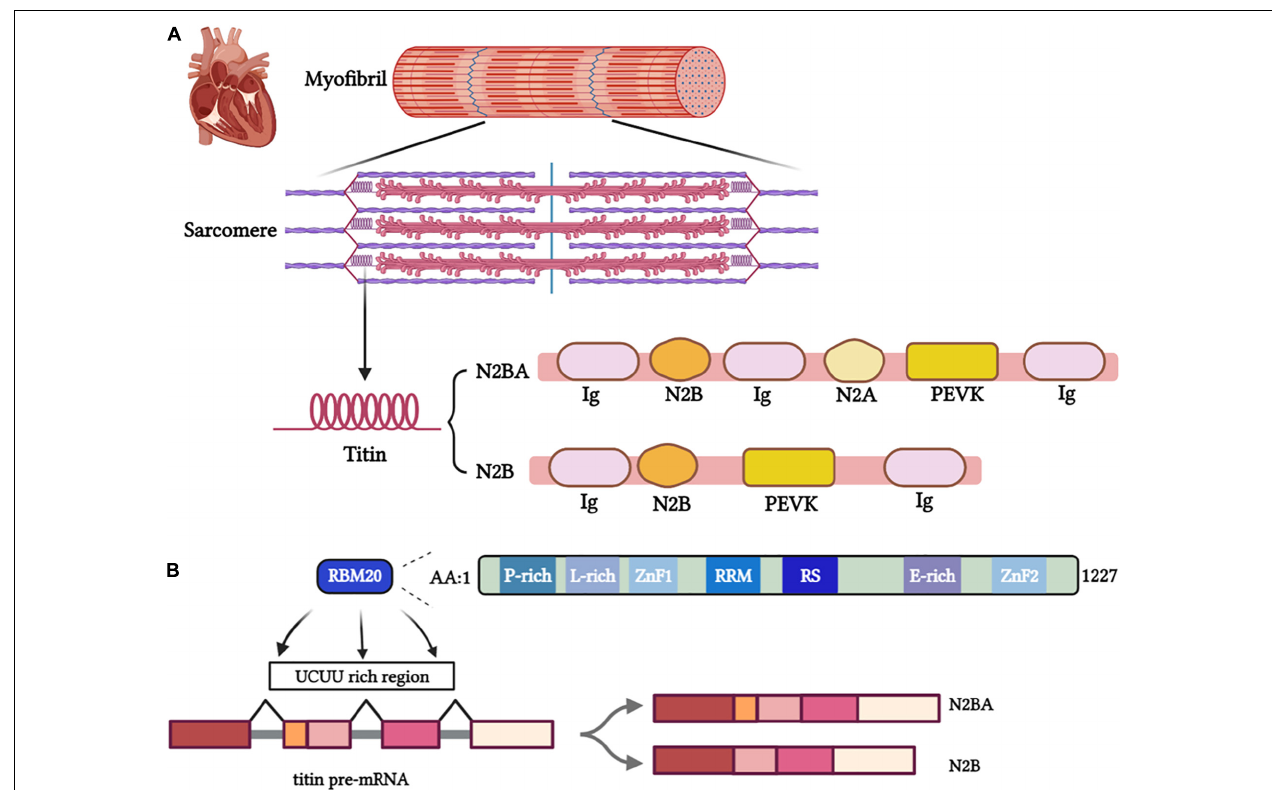
FIGURE 1 | (A) Titin isoforms serve essential functional roles as part of the sarcomere, myofibril, and cardiac tissue. (B) The binding site of RBM20 on pre-mRNA and the structural and functional domains of